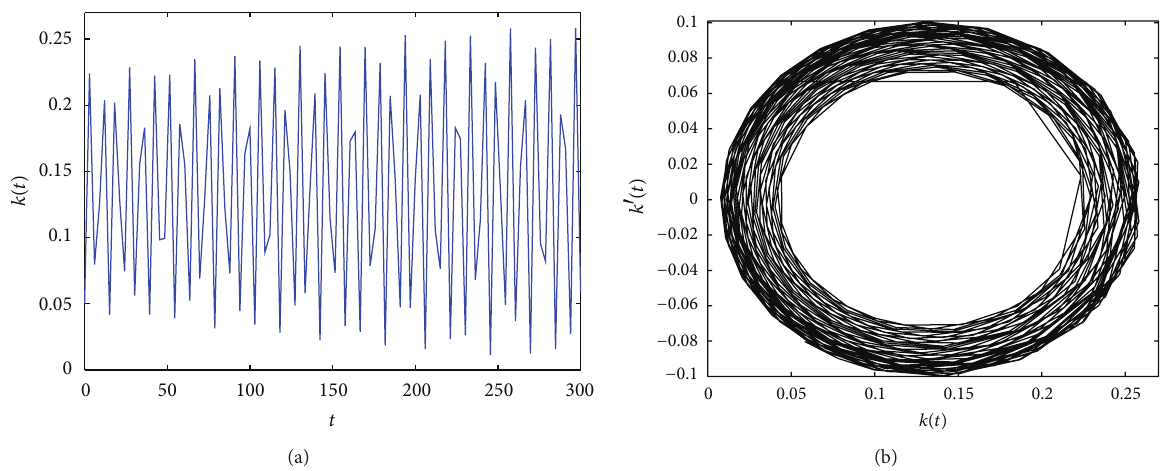
Figure 2: The time evolution of the function 𝑘(𝑡) for 𝑠 = 0.11 , 𝛿 = 0.8 , 𝛼 = 0.01 , 𝐴 = 1 , 𝜏 1 = 3 , and 𝜏 2 = 2 (a). The 𝑘 󸀠 (𝑡) versus 𝑘(𝑡) , for 𝑡 ∈ [0, 300]